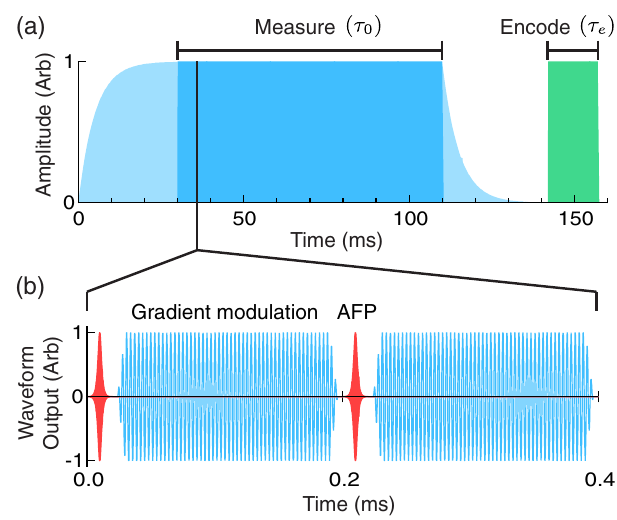
FIG. 6. NMR encoding and spin detection. (a) Timing diagram for a single MAGGIC measurement sequence. To minimize spurious mechanical excitation of the SiNW, the gradient modulation is turned on and off with an exponential envelope having a time constant of Q 1 / ð π f 8 ms (light blue regions.) 1 Þ ¼ The quality factor Q 1 and resonance frequency f 1 of the SiNW resonator are discussed in Appendix A. Dark blue areas indicate the readout period, during which the AFPs and the gradient modulation were applied simultaneously. The encoding time τ e varied between a few microseconds up to several milliseconds, depending on the desired encoding sequence. (b) Diagram showing the MAGGIC